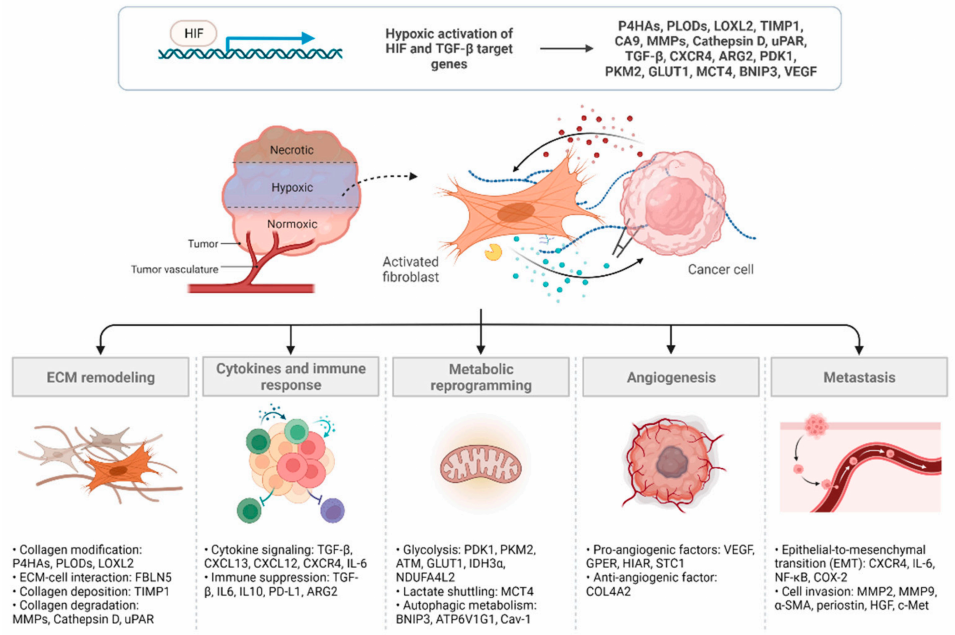
Figure 1. CAF-mediated cancer progression in hypoxia. Several mechanisms are involved in CAF- mediated cancer progression under hypoxia. HIF and TGF- β pathways play a major role in CAF activation and function. A number of genes have been demonstrated as direct transcriptional targets of HIF in either CAFs or cancer cells. Crosstalk between CAFs and cancer cells may alter ECM structure, immune responses, cell metabolism, angiogenesis, and metastasis through various signaling molecules (created with BioRender.com on June